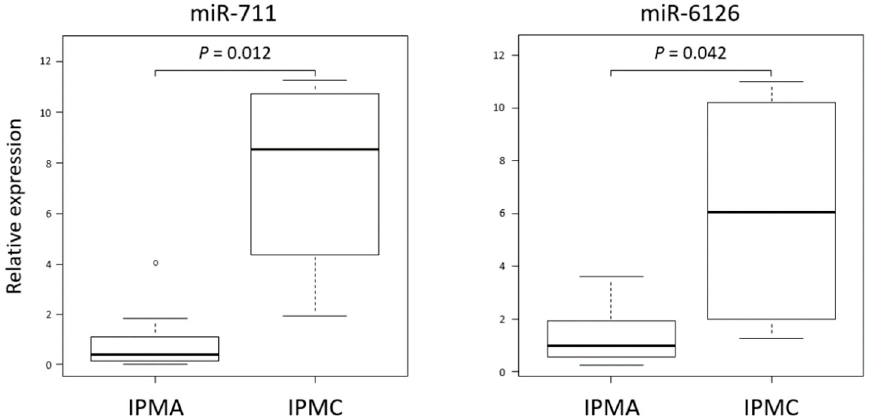
Figure 3. Quantifying the expression levels of miRNAs by real-time RT-PCR and validating the difference between IPMA and IPMC. Indicated two miRNAs in cyst fluid from IPMC were signifi- cantly higher level than those in IPMA. The data were analyzed by Mann–Whitney U test. Data are expressed as box-and-whisker plots. Within the boxes, the center lines denote the median values and boxes extend from the 25th to the 75th percentile of each group’s distribution of values. Vertical extending lines mean adjacent values, i.e., the most extreme values within 1.5 interquartile range of the 25th and 75th percentile of each group, and the value beyond the upper and lower bounds is considered an outlier marked with a white dot. A p -value < 0.05 considered a significant difference between the groups. IPMC, intraductal papillary mucinous carcinoma; IPMN, intraductal papillary mucinous neoplasm.